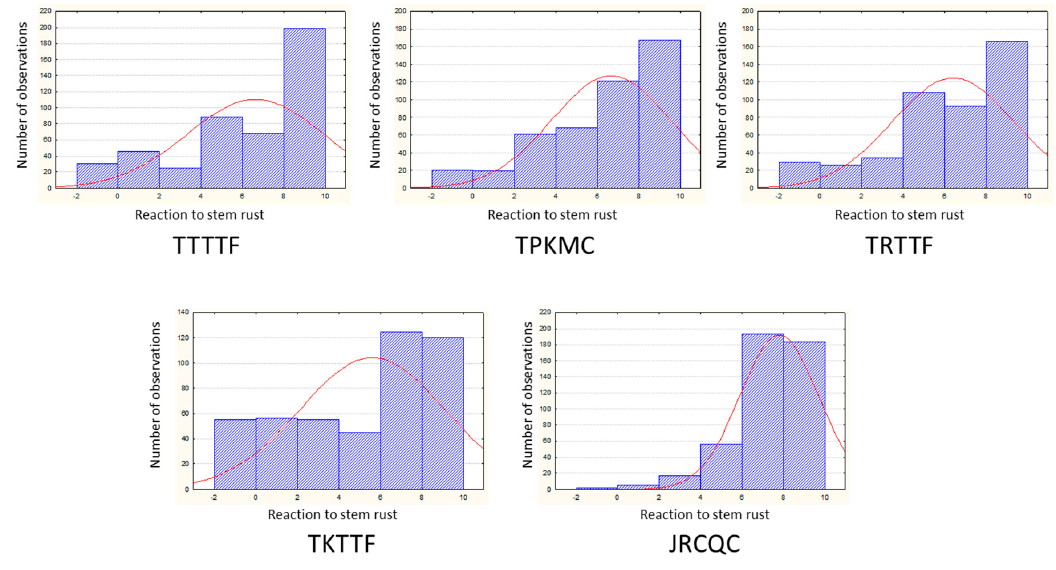
Figure 1. Distribution frequencies for the reactions of the whole collection to the five races of Puccinia graminis f. sp. tritici .